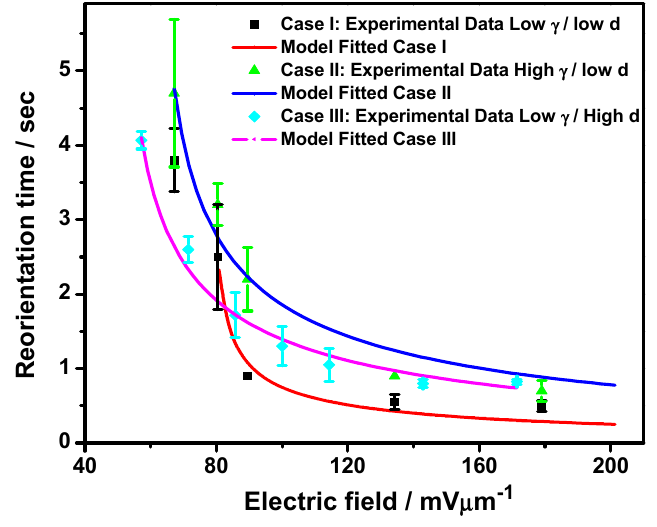
Figure 4. The averaged reorientation time of representative GP flakes with different NLC host-types and cell thicknesses as a function of the electric field (Case I: low γ , low d ; Case II: high γ , low d ; Case III: low γ , high d ). The scattered points represents experimental data, along with measurement error bars and the lines, are model fitted with Y = P 1 /( X 2 + P 2 ) 0.5 following Equation (4), where P 1 is the numerator of Equation (4), and P 2 is the constant part in the denominator of Equation (4) divided by coefficient of E 2 . Error bars for respective data points are assigned considering the standard deviations obtained of repetitive observations.